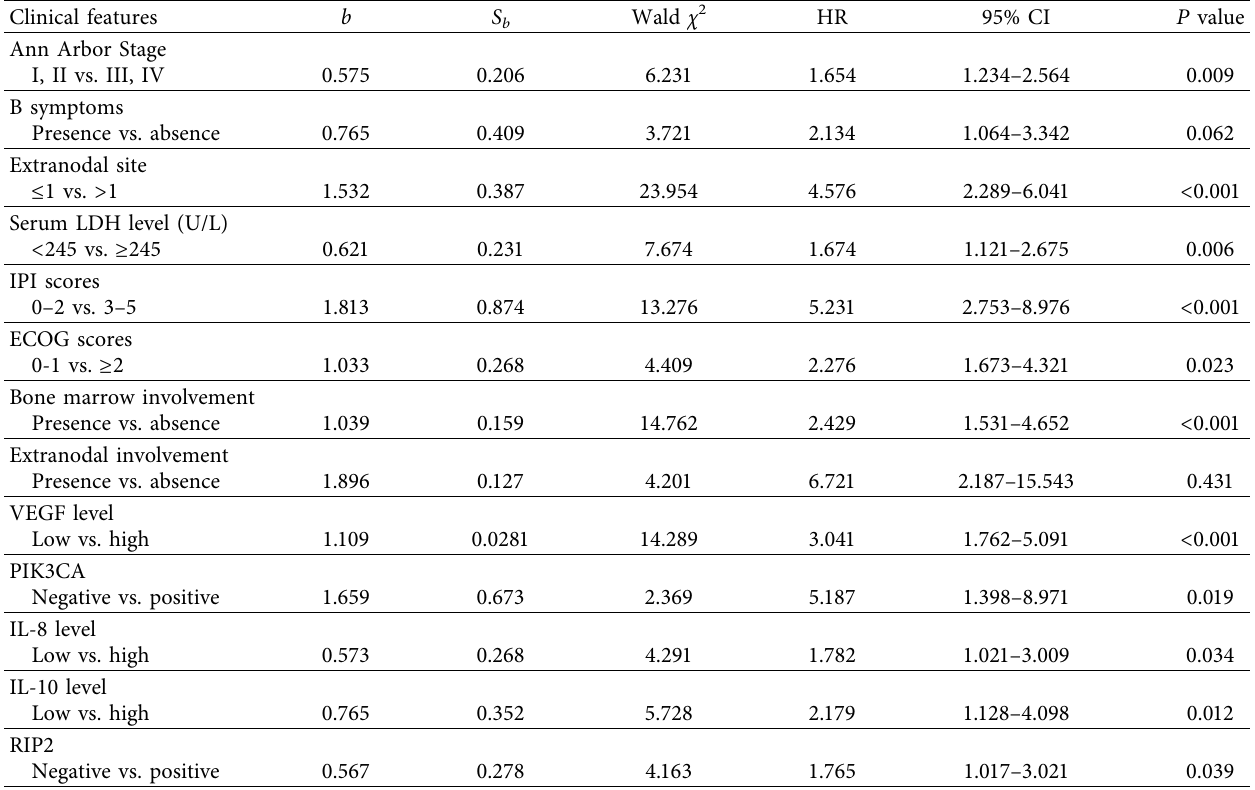
Table 3: Multivariate Cox proportional hazard regression analysis of